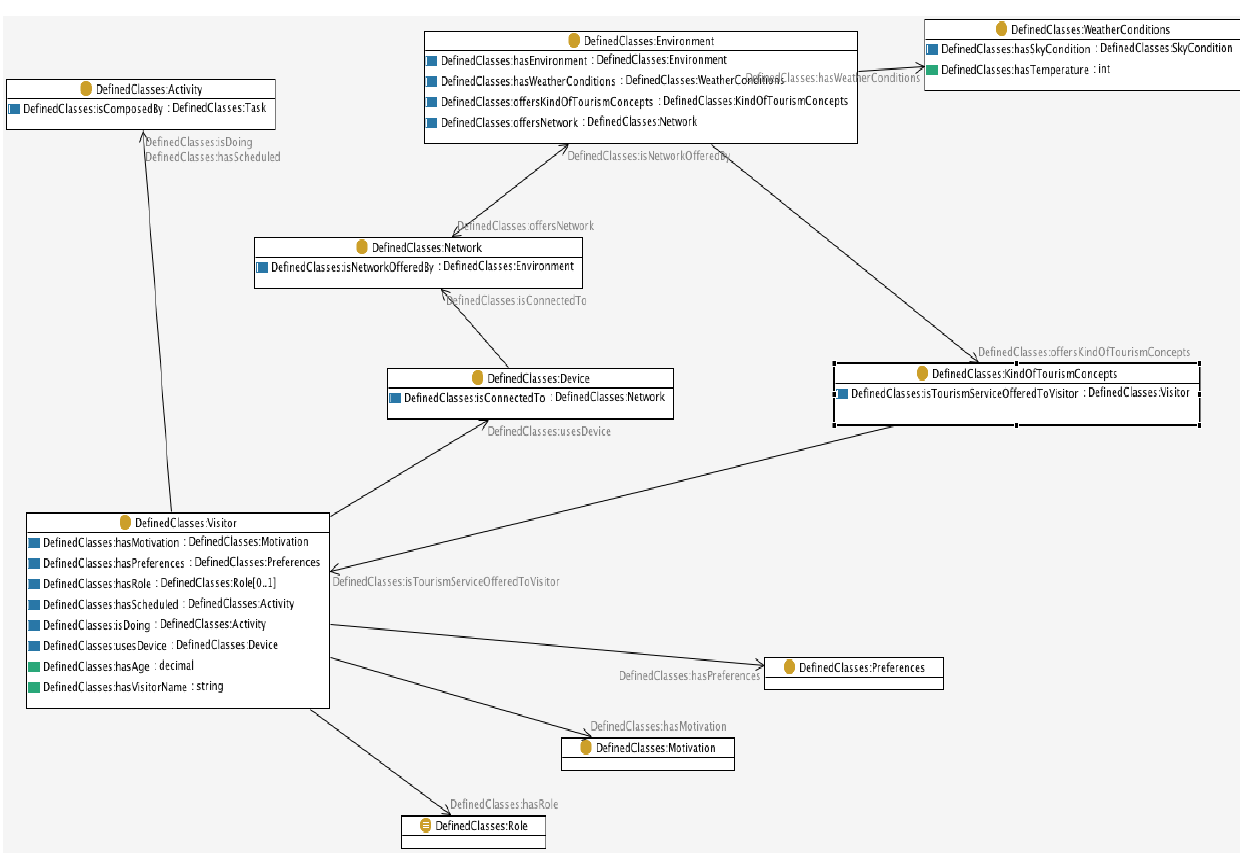
Figure 2. High level view of the ContOlogy network of